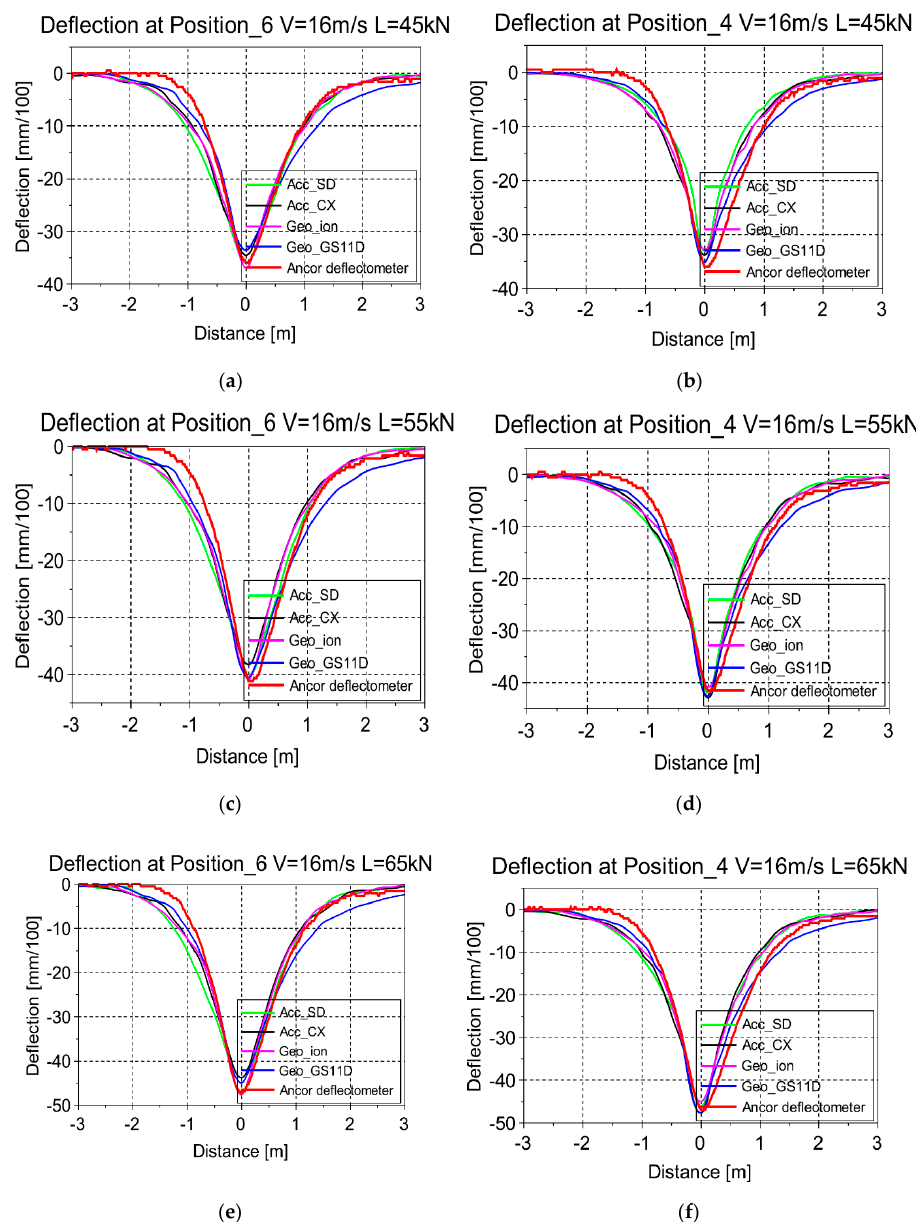
Figure 17. ( a ): Deflections at position 6 and 45 kN load. ( b ): Deflections at position 4 and 45 kN load . ( c ): Deflections at position 6 and 55 kN load. ( d ): Deflections at position 4 and 55 kN load . ( e ): Deflections at position 6 and 65 kN load. ( f ): Deflections at position 4 and 65 kN load.